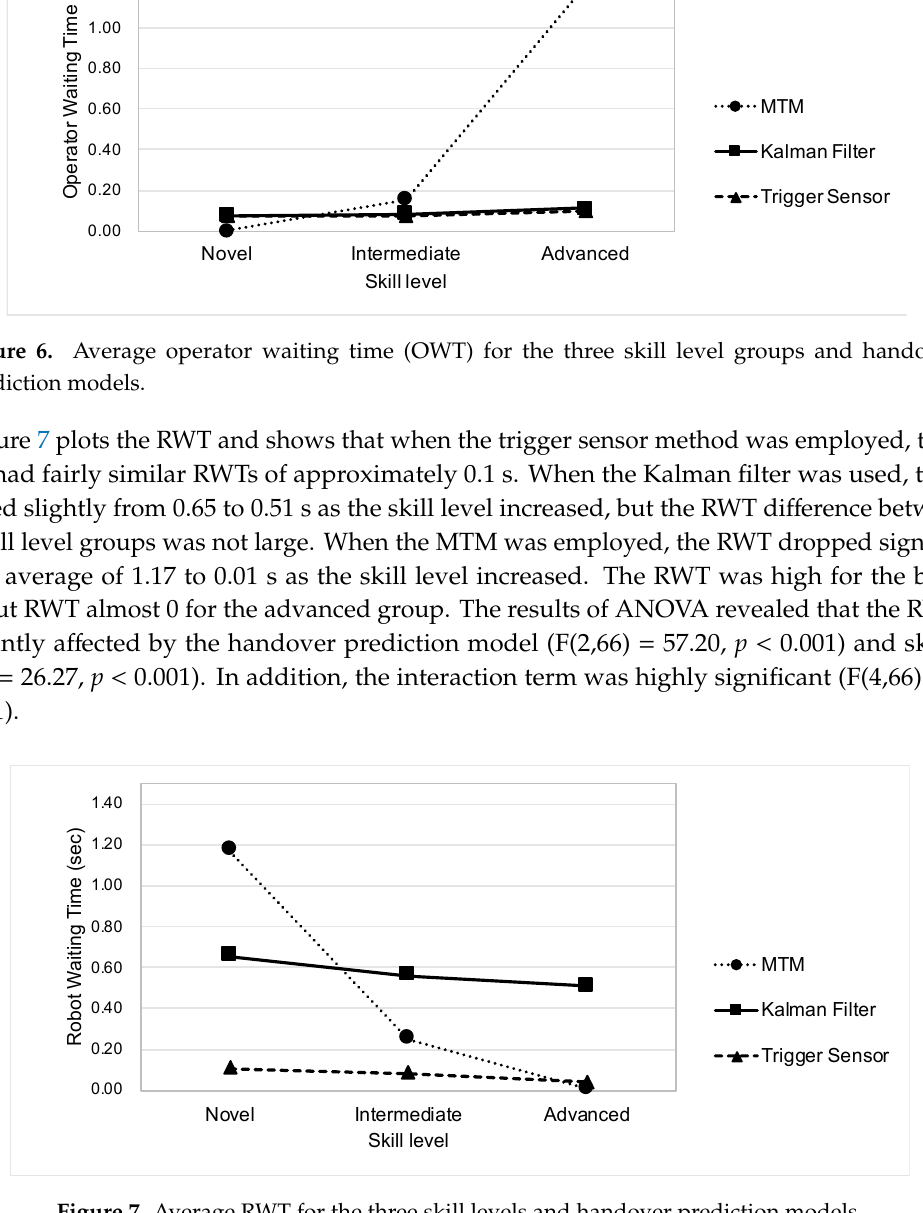
Figure 7. Average RWT for the three skill levels and handover prediction models.